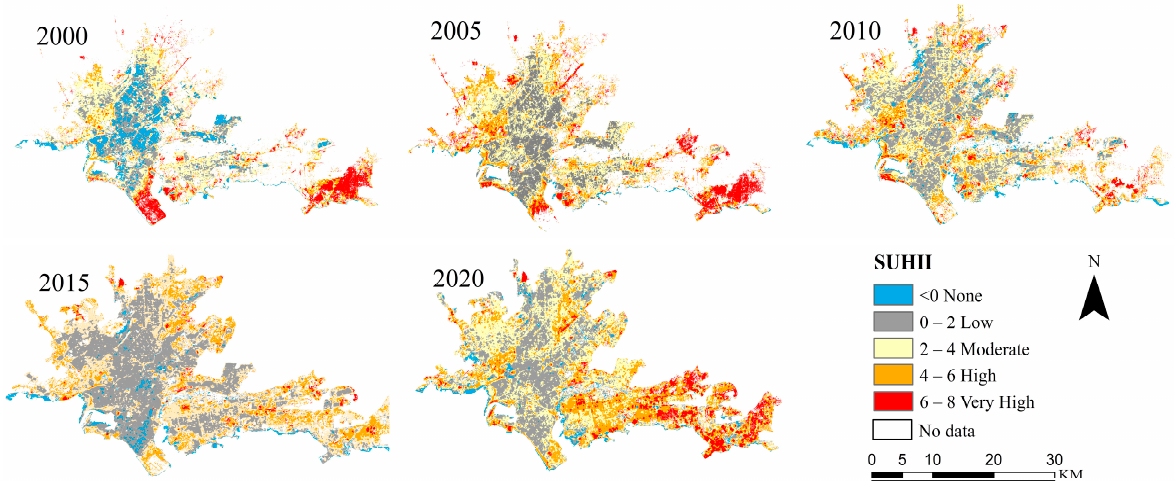
Figure 6. Spatial patterns in the SUHII (°C) in the study area for five different years during the period 2000–2020.